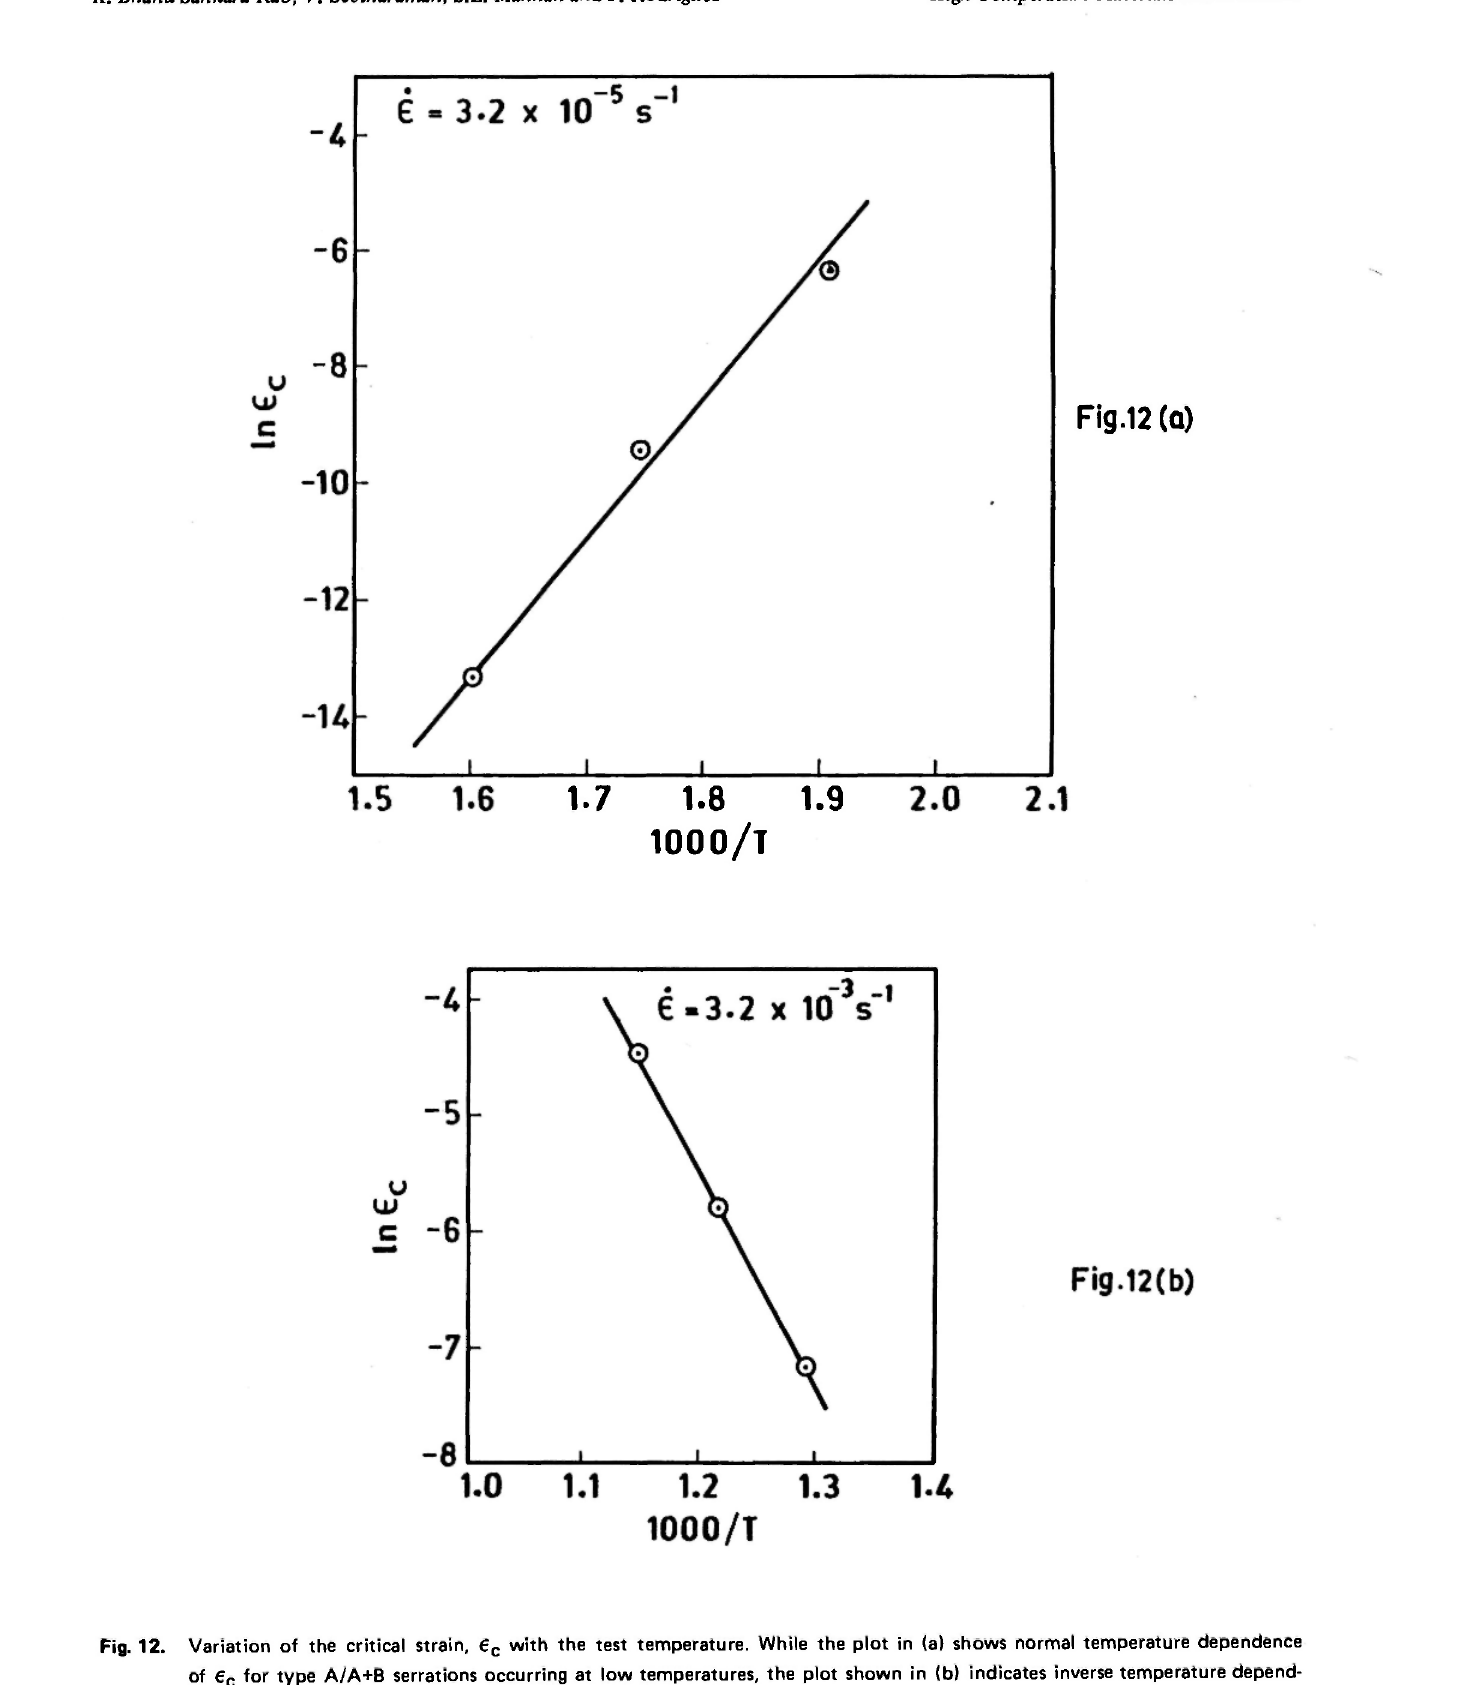
Fig. 12. Variation of the critical strain, e c with the test temperature. While the plot in (a) shows normal temperature dependence of e c for type A/A+B serrations occurring at low temperatures, the plot shown in (b) indicates inverse temperature depend- ence of € c for type C serrations occurring at Τ > 673